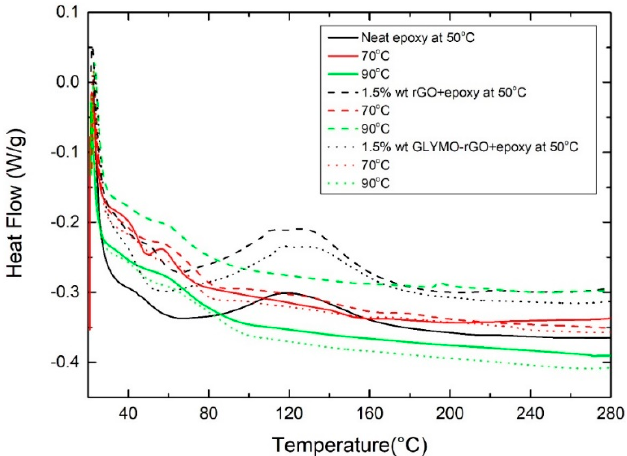
Figure 9. Subsequent non-isothermal DSC scans at a constant heating rate of the partially cured samples derived from the isothermal scans.